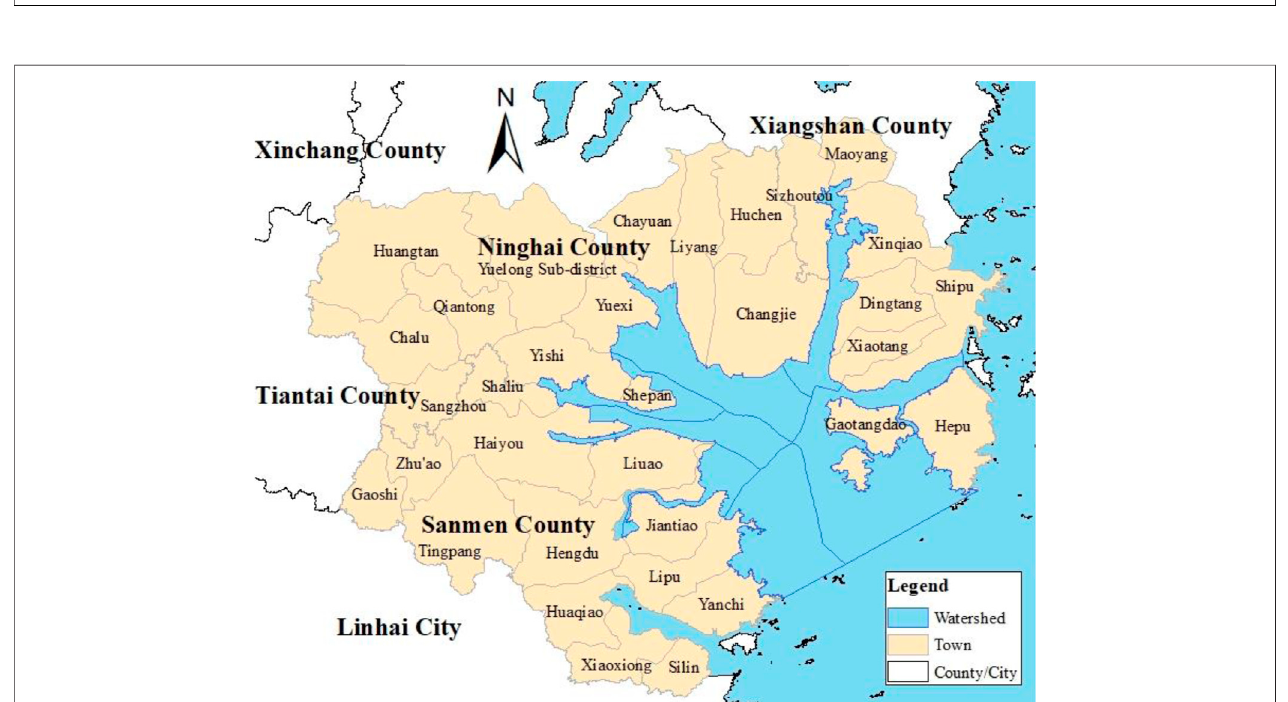
FIGURE 2 | Administrative map of Sanmen